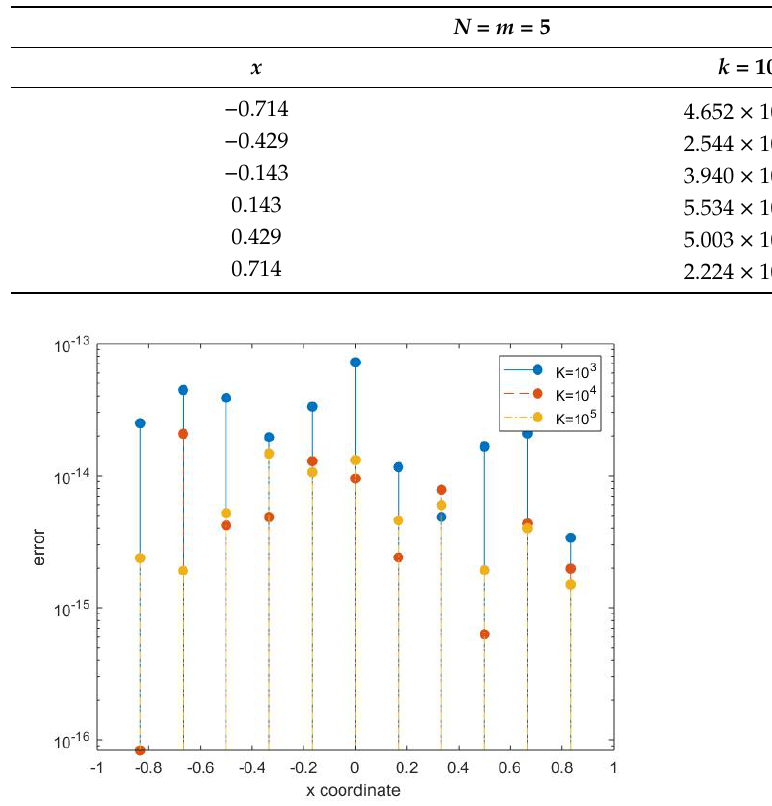
Figure 4. The absolute error for N = 10, m =